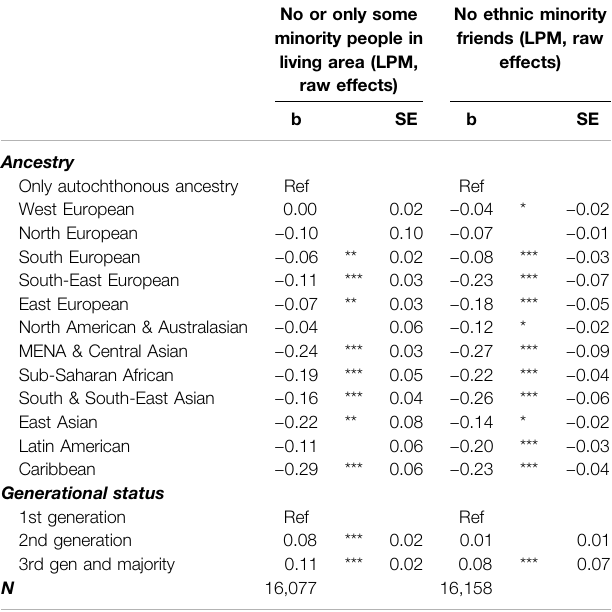
TABLE 7 | Regression models for social integration (main effects models, ESS7 only).